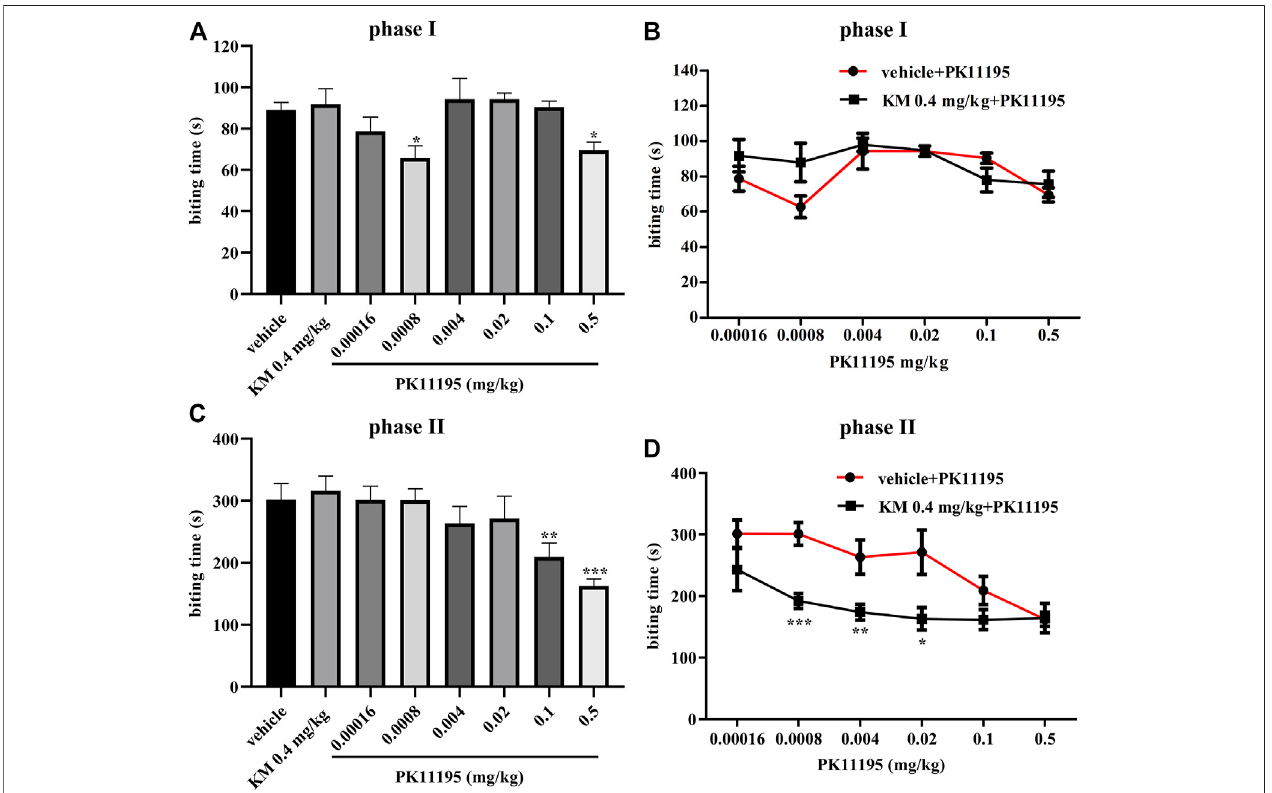
FIGURE1| KoumineaugmentsPK11195-mediatedanalgesiceffectsintheformalintestinmice. (A,C) DoseresponseeffectsofkoumineandPK11195onphaseI (A) and phase II (C) in the formalin test. (B, D) Dose response curves for PK11195 in the absence or presence of koumine (0.4 mg/kg) on phase I (B) and phase II (D) in the formalin test. PK11195 and koumine were injected s.c. 30 min or 40 min prior to formalin administration, respectively. To assess the interaction between koumine and PK11195, separate groups of mice were administrated koumine or vehicle and 10 min later PK11195 were given. Abbreviations: KM, koumine. Data are represented asthemean ± SEM, * p < 0.05, ** p < 0.01and *** p < 0.001 vs. thecorrespondingvehicle group. Thecomparison between thetwo groupswasanalyzedby independent samples t -test, and multiple comparisons were compared by one-way ANOVA followed by LSD post hoc test. Each group consisted of 7 – 10 mice.